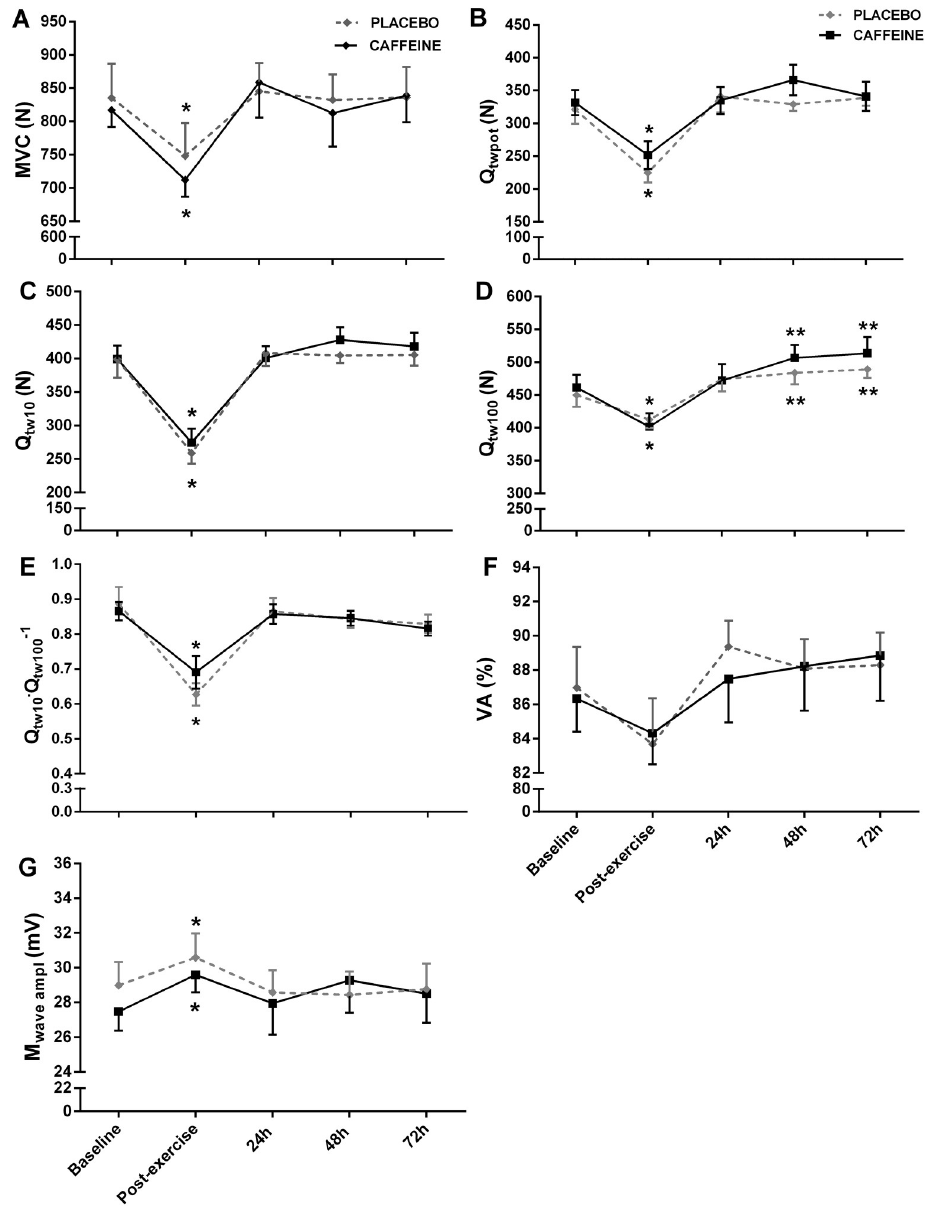
Fig 4. Countermovement jump test performed before and after a half-squat exercise and at 24, 48 and 72 h after placebo or caffeine ingestion. Values are expressed as mean ± SEM. A: Height; B: Power (relative to body mass). � Significantly higher than pre- and post half-squat exercise in both conditions; # Significantly higher than pre- and post half-squat exercise only in caffeine condition; † Significantly higher than placebo at the same time point.